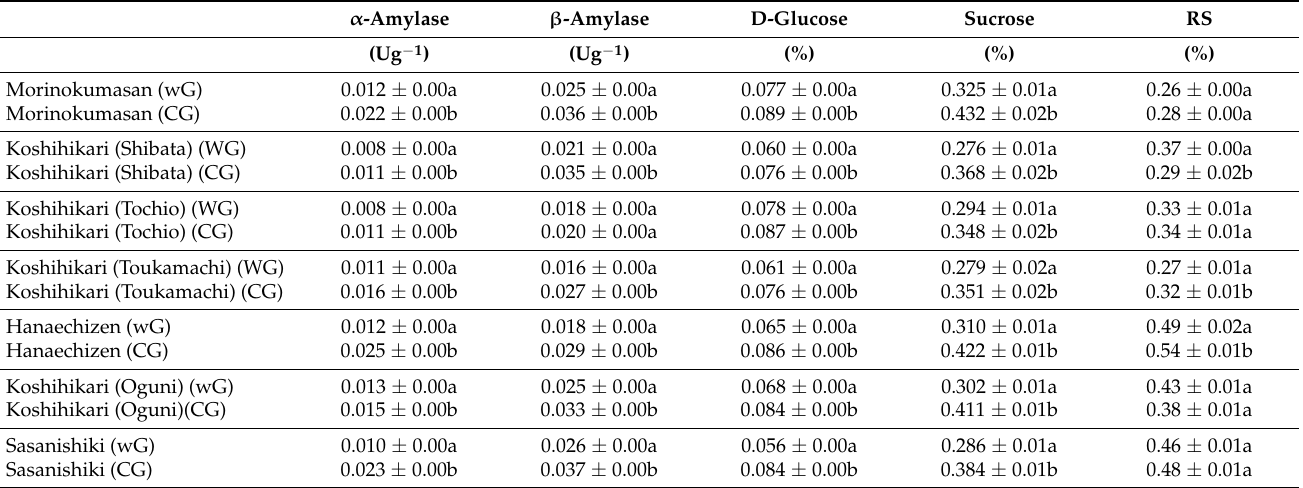
Table 5. Starch-hydrolyzing enzyme activities, sugar contents and resistant starch contents of whole and chalky rice grains from 7 Japonica rice samples in